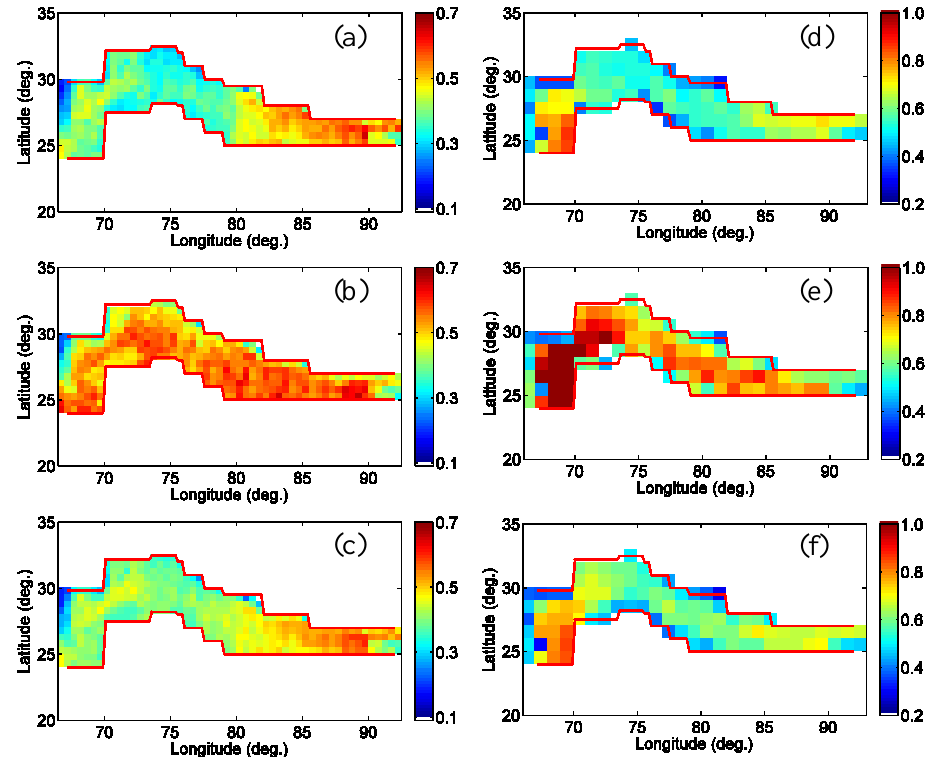
Figure 5. Spatial distribution of multiyear average (2000–2012) AOD in the IGB region for the months of April (top row a and d ), May (middle row b and e ), and the MAM average (bottom row c and f ) from MISR (left column) and MODIS (right column). Notice difference in scales between the MISR and MODIS color